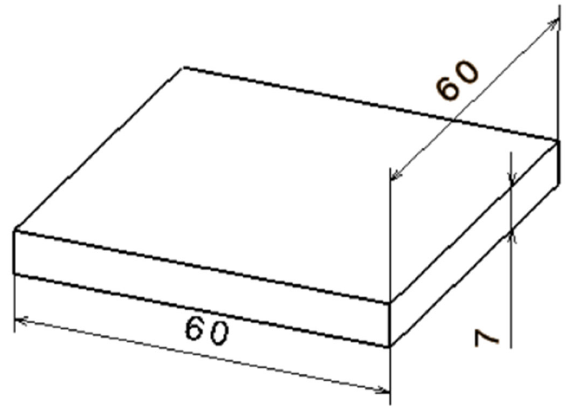
Figure 3. Onyx 3D ‐ printed specimen sketch. Figure 3. Onyx 3D-printed specimen sketch.